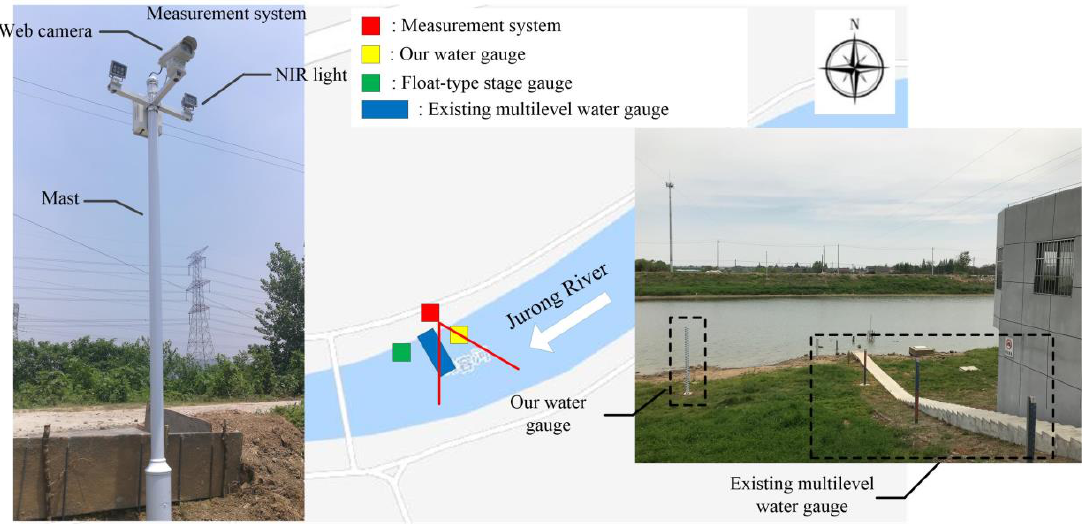
Figure 1. Measurement system at site